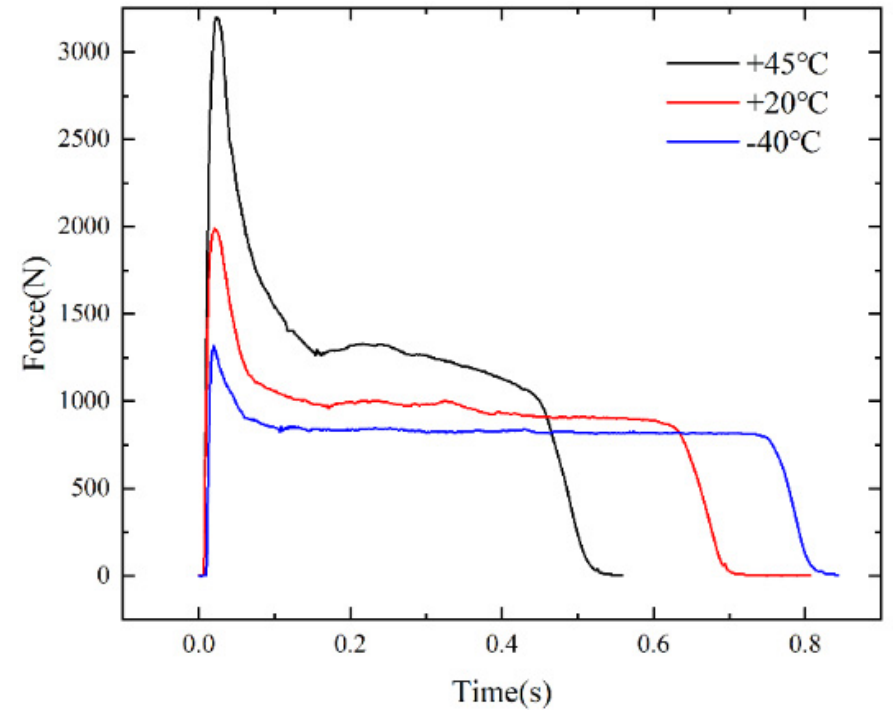
Figure 12. Curves of rocket thrust. Table 3. Main parameters of